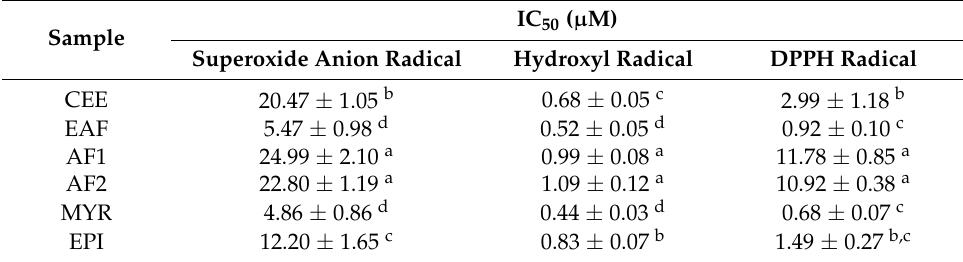
Table 3. IC 50 (half maximal inhibitory concentration, µ M) of different extracts and standards in superoxide anion, hydroxyl and DPPH (1,1-diphenyl-2-picrylhydrazyl) radical scavenging assays. Each value in the table is represented as Mean ± SD ( n = 3). Means not sharing the same letter are significantly different at p < 0.05 probability level in each column. CEE: Crude Ethanolic Extract; EAF = Ethyl acetate Fraction, AF1 = Aqueous Fraction 1, AF2 = Aqueous Fraction 2, MYR = Myricitrin Standard, EPI = Epicatechin